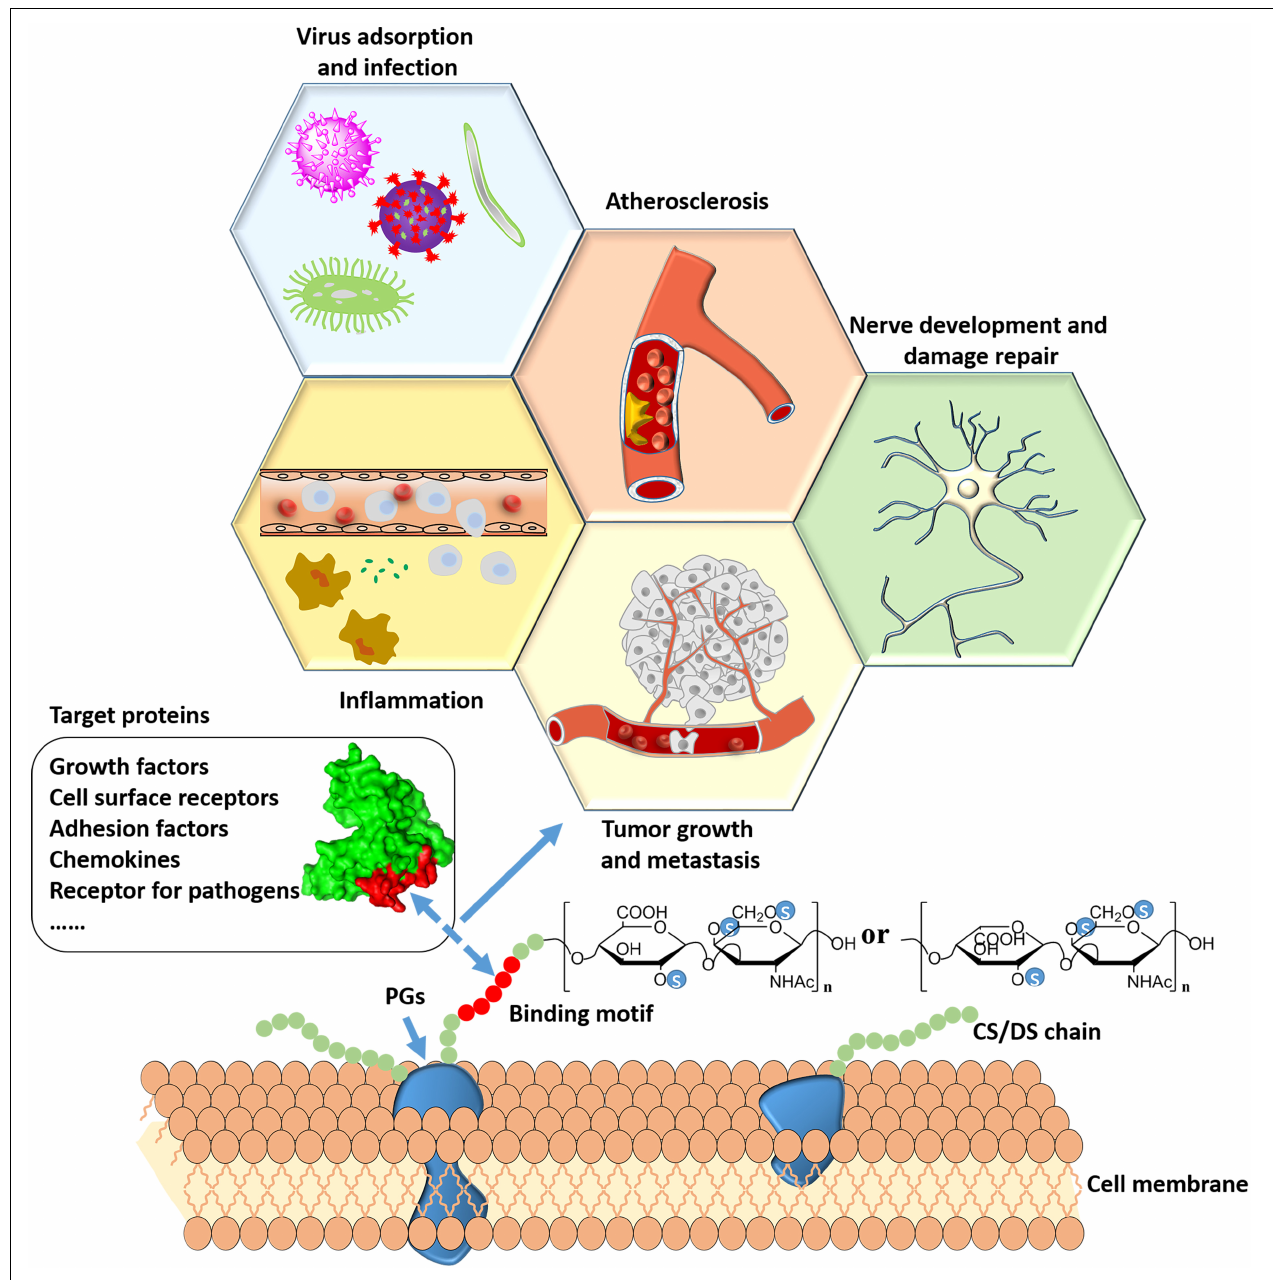
FIGURE 3 | Major diseases that are related to interactions between CS/DS and